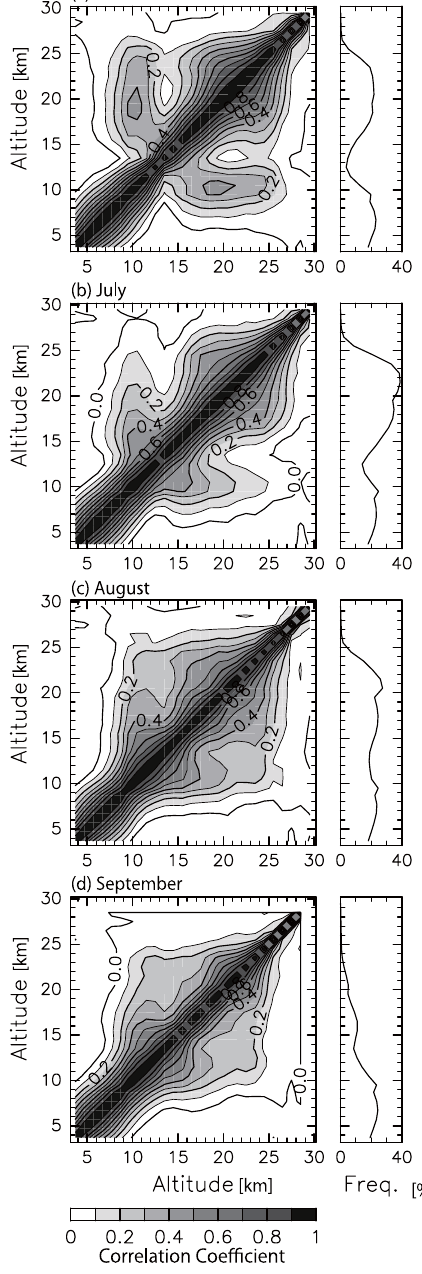
Fig. 3. Correlation coefficients between PSC/UC frequencies at dif- ferent altitudes for (a) June, (b) July, (c) August, and (d) September from 2007 to 2011. The correlation coefficients greater than approx- imately 0.16 are statistically meaningful at a significance level of 99%. The right panel shows PSC/UC frequency as a function of altitude (%).